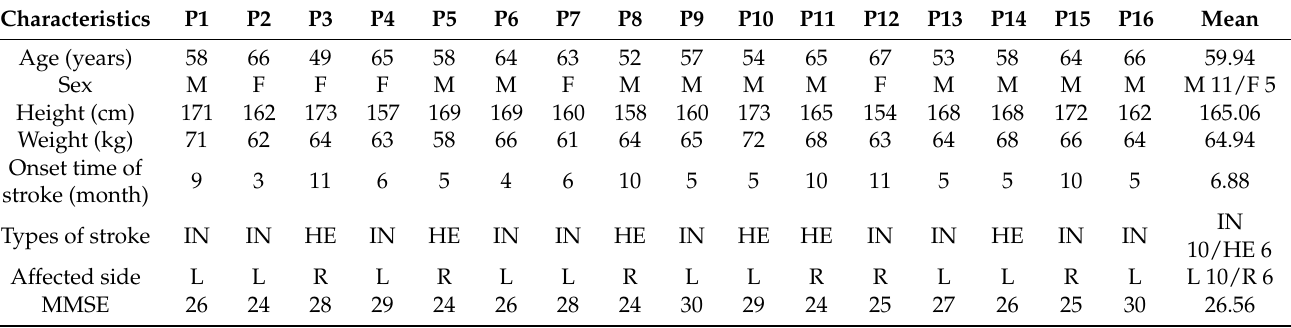
Table 1. General characteristics of the